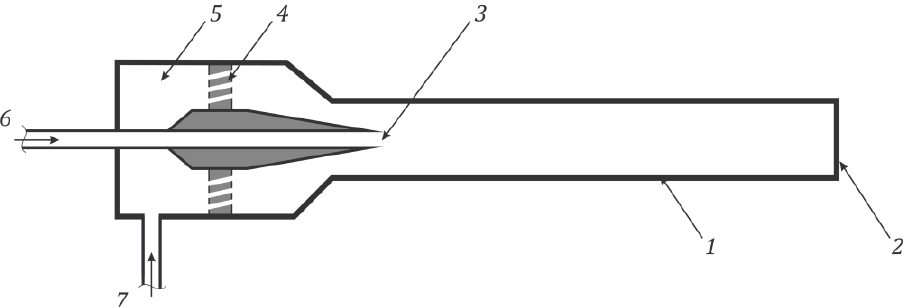
Fig. 2. Scheme of the ejector nozzle used in cold spray: 1 – nozzle, 2 – exit section, 3 – input particles, 4 – honeycomb, 5 – prechamber, 6 – powder feed, 7 – gas feed spray unit on industrial